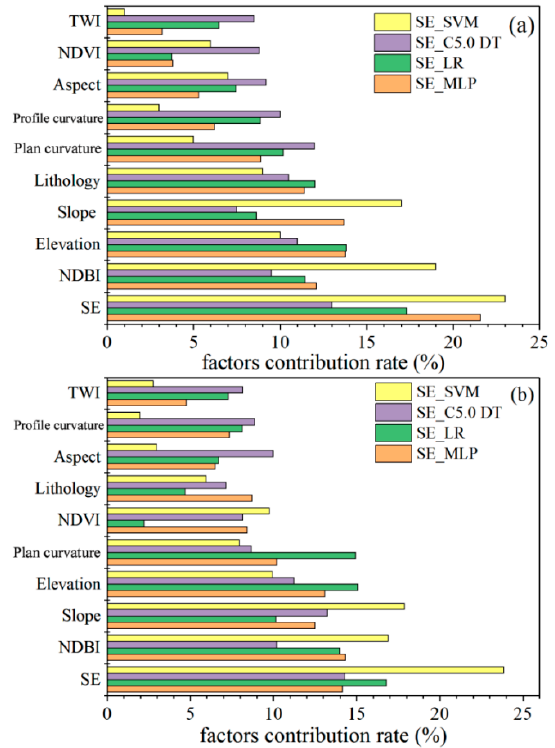
Figure 8. Relative importance of landslide factors in different models with 30 m ( a ) and 60 m ( b ) resolutions. ( b )